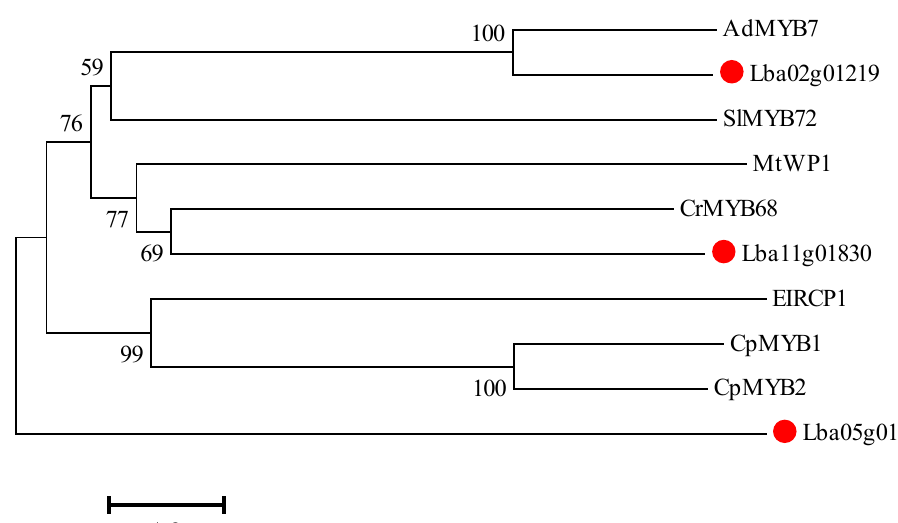
Figure 10. Phylogenetic analysis of candidate and seven function-known R2R3-MYB genes from other species. The maximum-likelihood method was used to construct the phylogenetic tree. The Genebank accession numbers are as follows: AdMYB7 (AXP34749.1), CrMYB68 (ASK51185.2), SIMYB72 (Solyc07g055000), EIRCP1 (KR053165.1), CpMYB1 (XP_021903563.1), and MtWP1 (Medtr0197s0010). Three candidate-LbaR2R3-MYB genes ( Lba02g01219 , Lba11g01830, and Lba05g01910 ) are marked with a red dot.